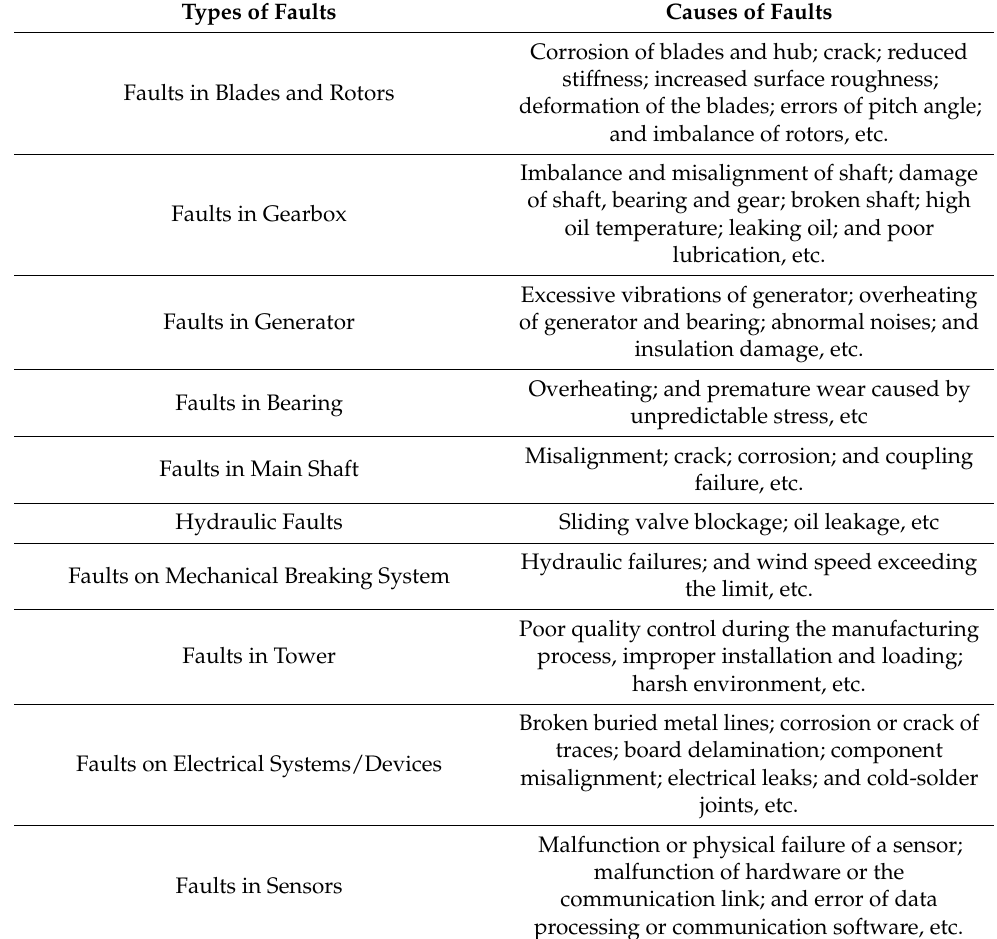
Table 1. Common faults in wind turbines